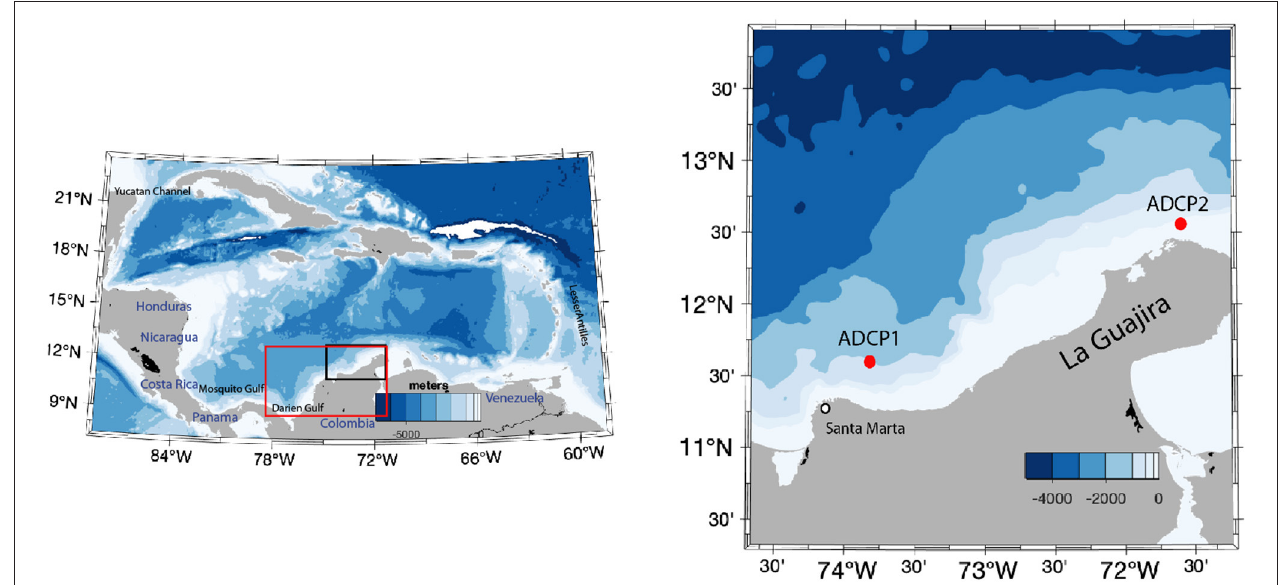
FIGURE 1 | Bathymetry of the Caribbean Sea (left) . The black box indicates La Guajira peninsula with the detailed bathymetry in the (right) and the red box the area used for the SOM analysis. Red dots in the right panel indicate location of the two